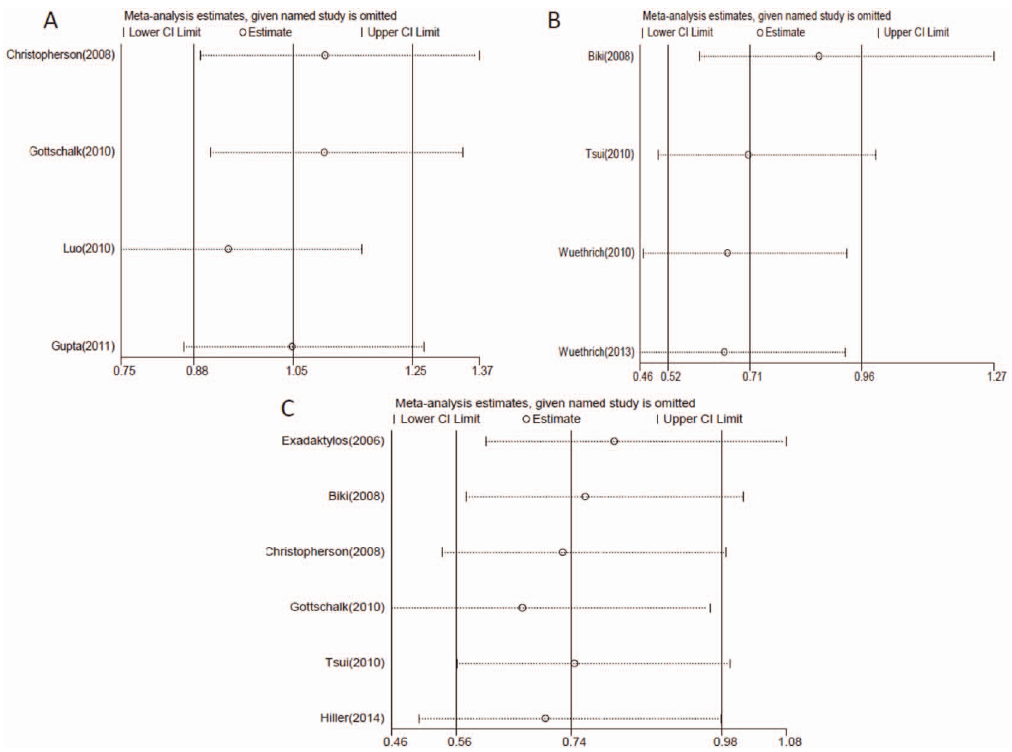
Fig. 3. Sensitivity analyses for included studies. A. all studies concerning colorectal cancer; B. all studies concerning prostate cancer; C. studies with follow-up less than or equal to two